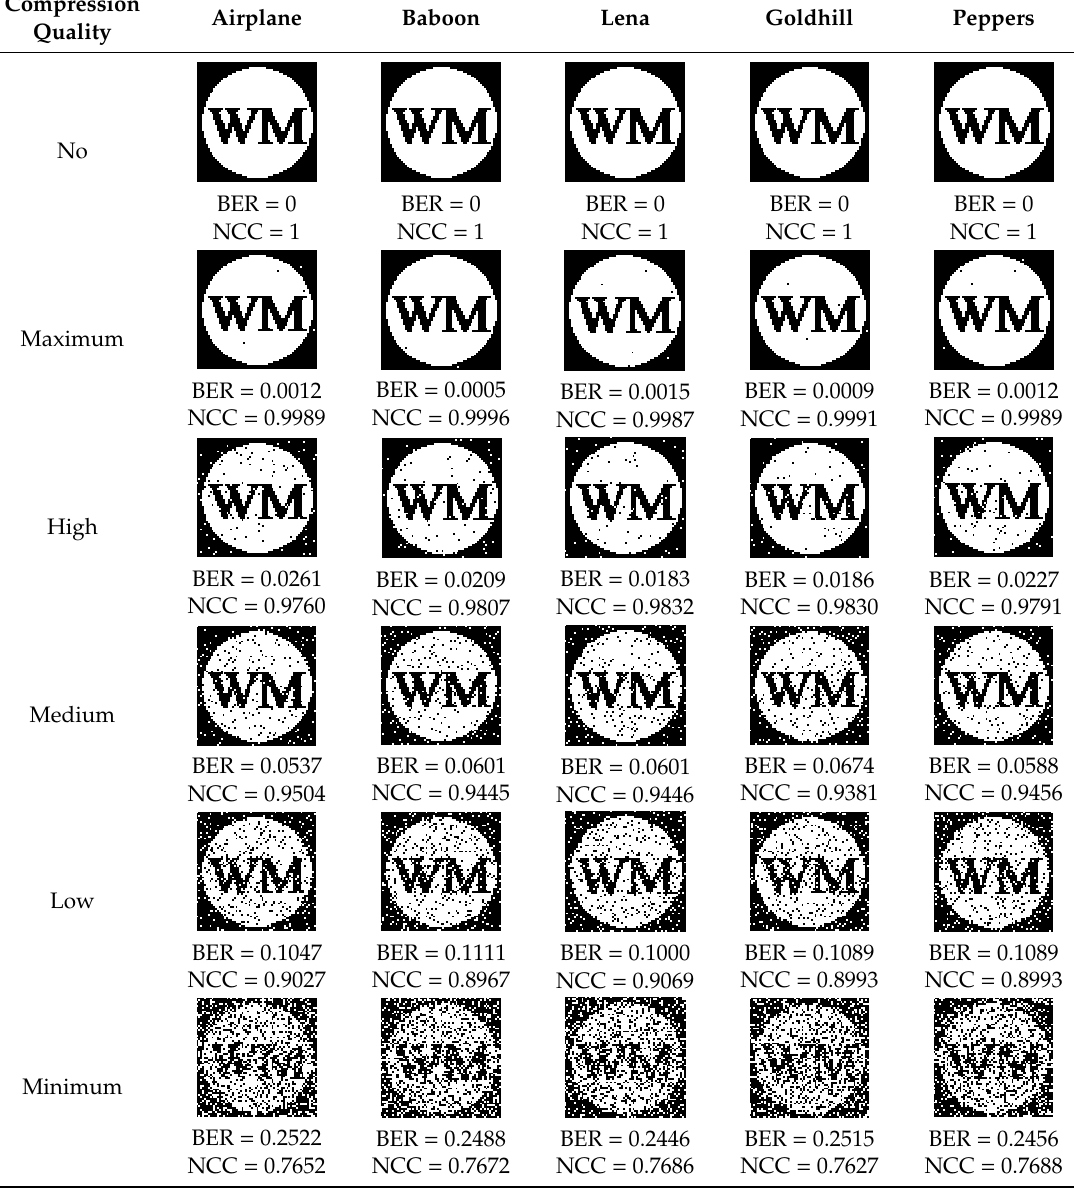
Table 2. Watermarks extracted from highly detailed watermarked images obtained by the algorithm [31].